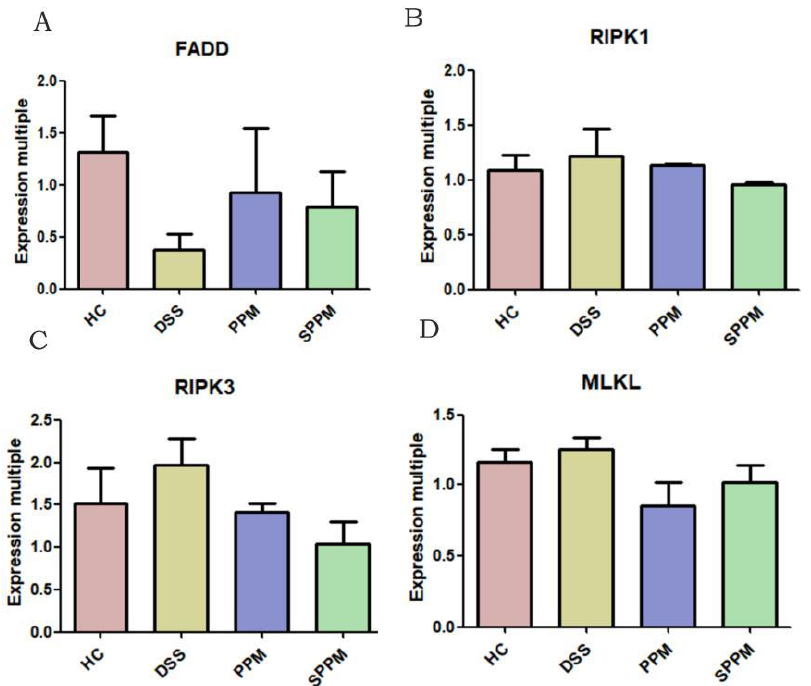
Figure 6. Effects of PPM60-III and SPPM60-III on genes related to necroptosis in mice. ( A ) RIPK3 ; ( B ) RIPK1 ; ( C ) MLKL ; ( D ) FADD ( B ) RIPK1 ; ( C ) MLKL ; ( D ) FADD .